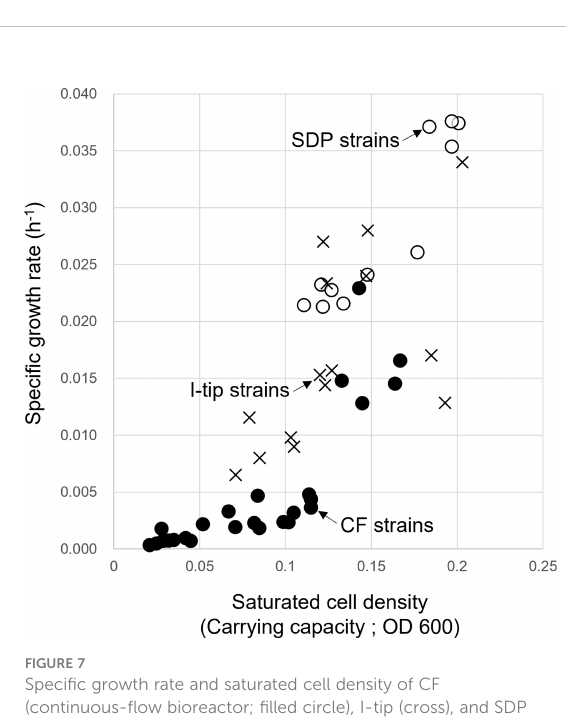
FIGURE 7 Speci fi c growth rate and saturated cell density of CF (continuous- fl ow bioreactor; fi lled circle), I-tip (cross), and SDP (standard direct plating; open circle) strains. Data for speci fi c growth rate and saturated cell density of SDP strains have already been reported (Jung et al.,